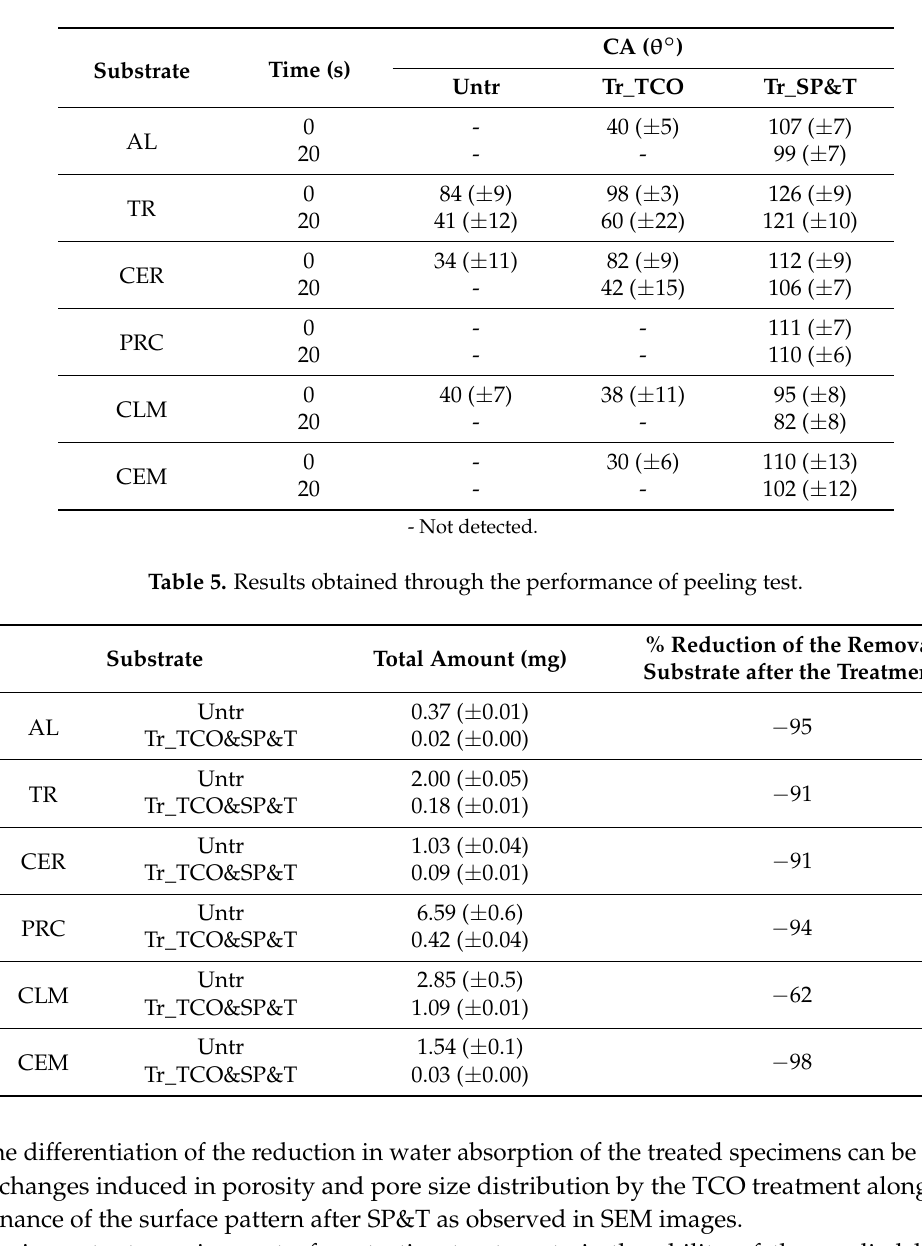
Table 4. Contact Angle ( θ ◦ ) measurements of untreated and three-layered treated surfaces.